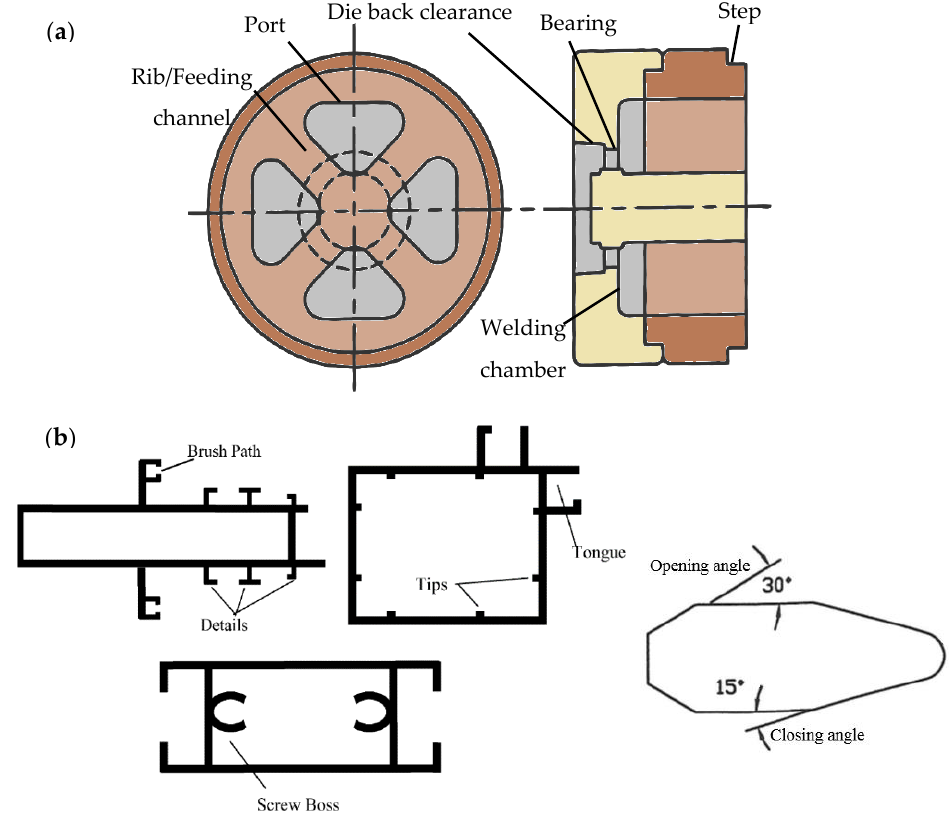
Figure 1. ( a ) Main features of a hollow-profile die; ( b ) some typical features of an extruded profile ( left ), and details of a rib profile ( right ).